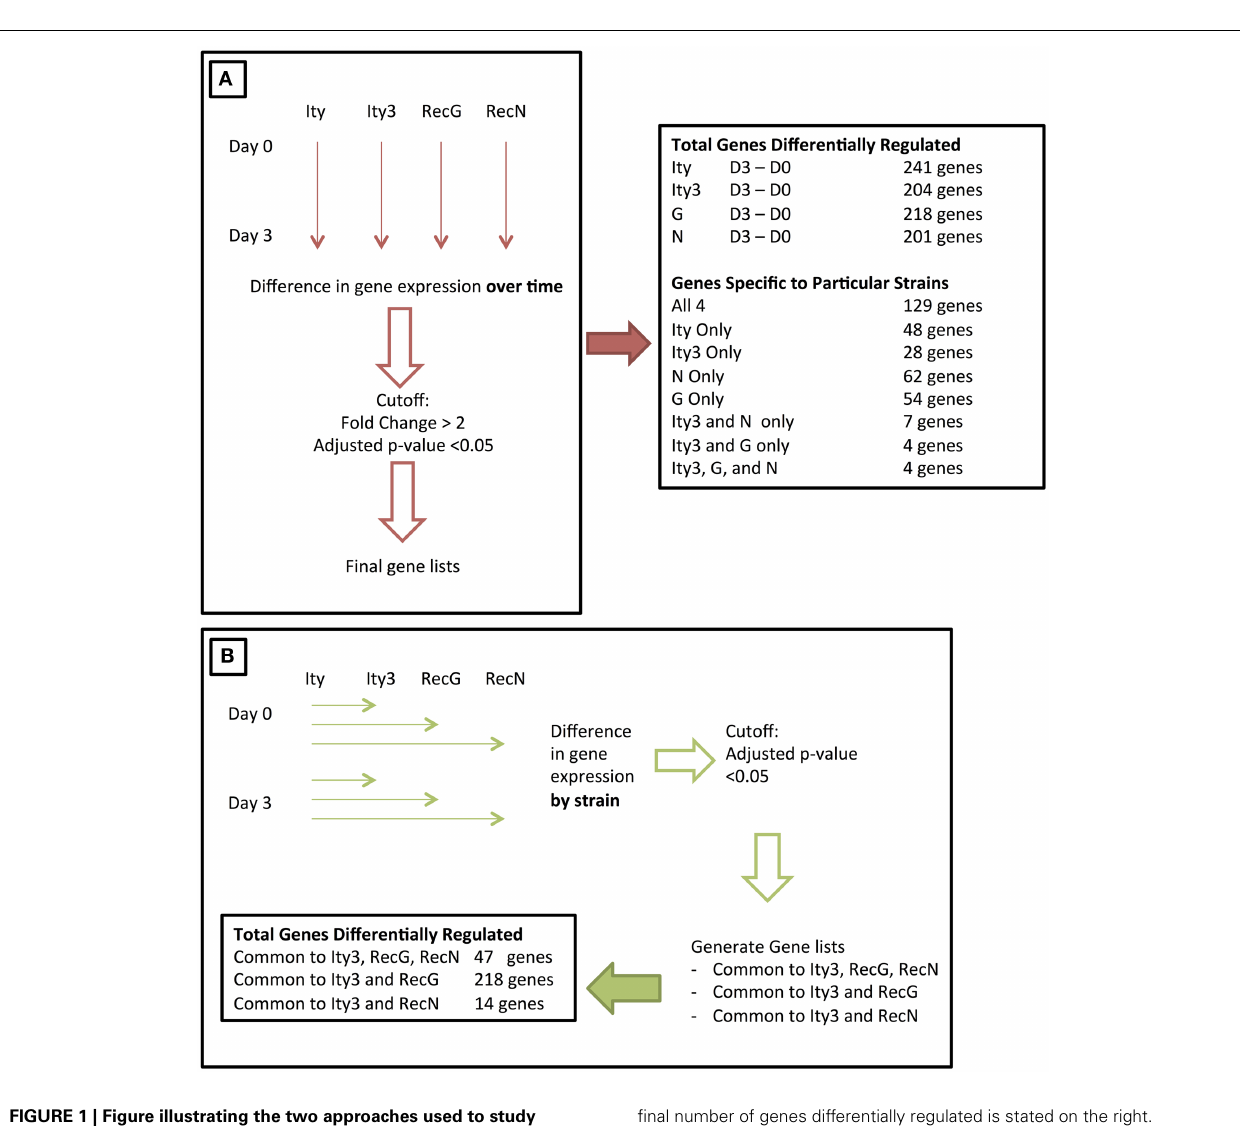
FIGURE 1 | Figure illustrating the two approaches used to study the changes in gene expression during infection of congenic and sub-congenic mice . (A) A representation of an initial approach used for studying the change in gene expression over time.The gene expression at day 3 post-infection was compared to day 0, and the